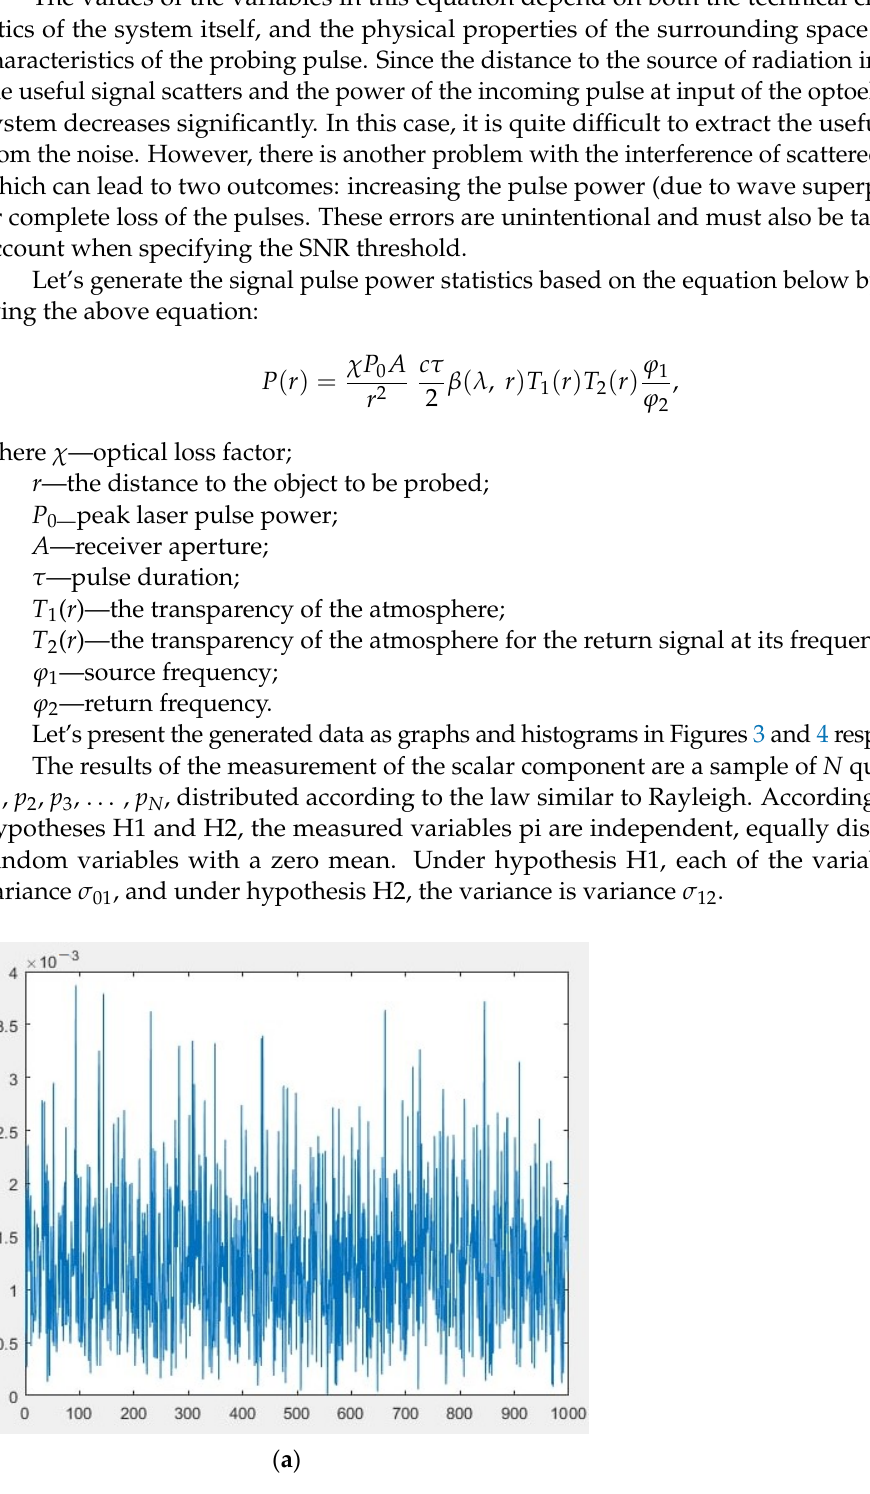
( b ) Figure 3. Generated power data for hypothesis H2: ( a ) power data for N = 1000; ( b ) histogram of observed data.